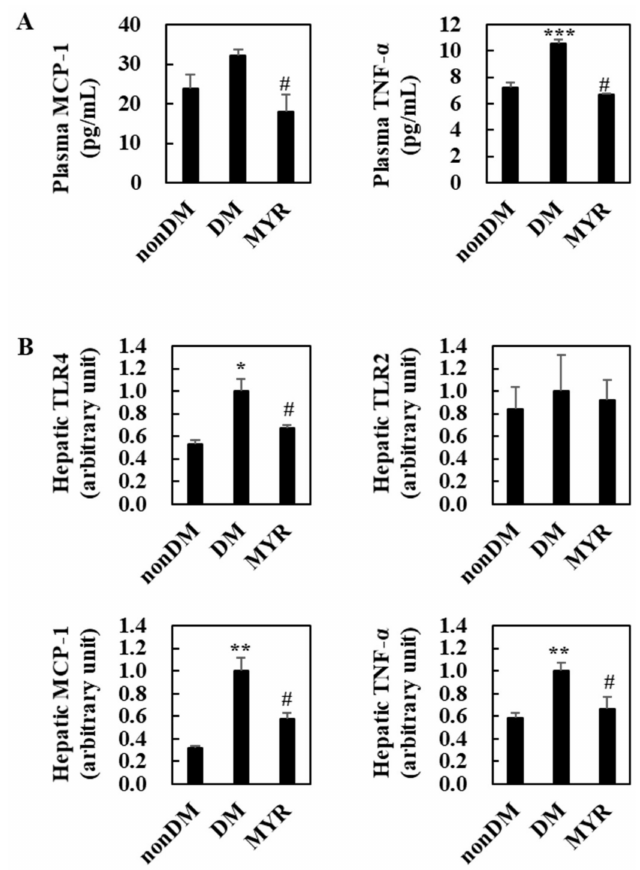
Figure 4. E ff ects of MYR on plasma pro-inflammatory MCP-1 and TNF- α levels ( A ) and hepatic pro-inflammatory genes mRNA expression ( B ) in HFD / STZ-induced diabetic mice. Values are means ± SE ( n = 10). Student’s t -test was used to assess the di ff erences among groups. * p < 0.05, ** p < 0.001, *** p < 0.001; non-DM group versus DM group, # p < 0.05; DM group versus MYR group.